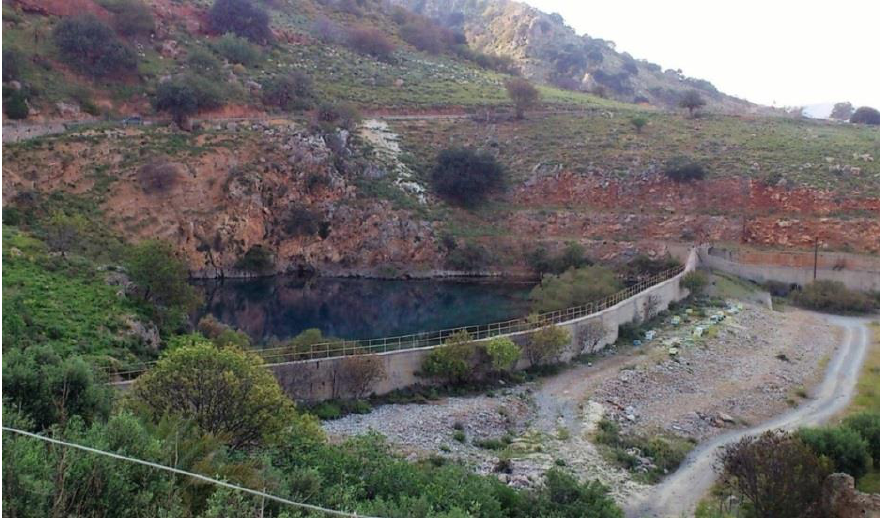
Figure 8. Almyros spring and the dam with a height of 10 m. Figure 9. Almyros spring and the dam with a height of 10